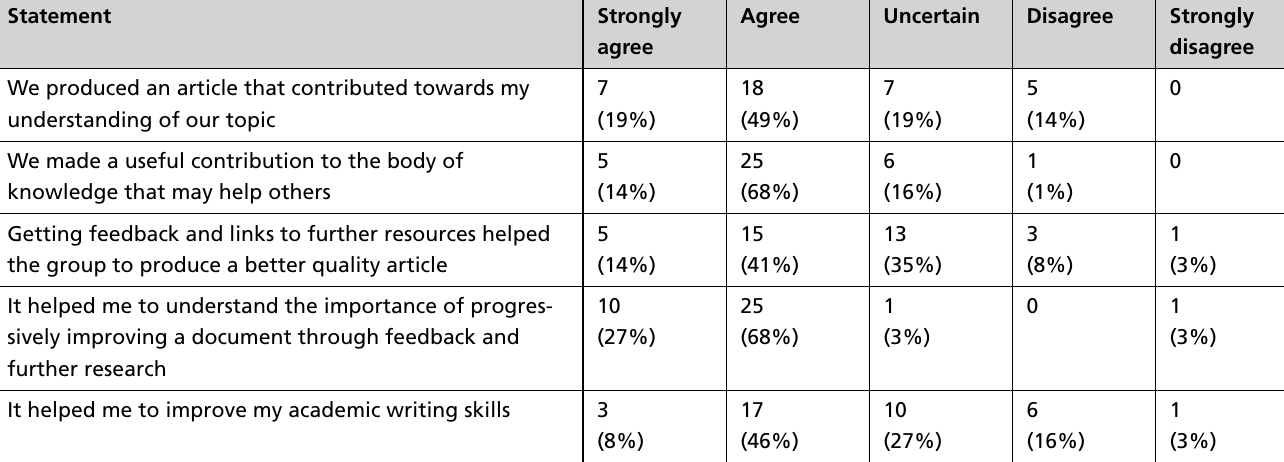
Table 1: Students responses around the use of a wiki to achieve the assignment learning outcomes